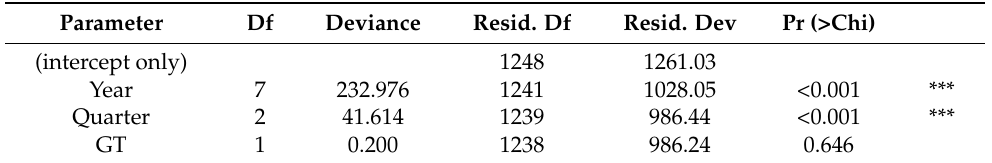
Table 2. Deviance table of the parameters used for the skipjack CPUE standardization using a generalized linear model (GLM) with gamma distribution. For each parameter, the degrees of freedom (Df), the deviance (Dev), the residual degrees of freedom (Resid. Df), the residual deviance (Resid. Dev), the Chi-square test statistic (Pr (>Chi)) and the significance ( p -value) are shown.